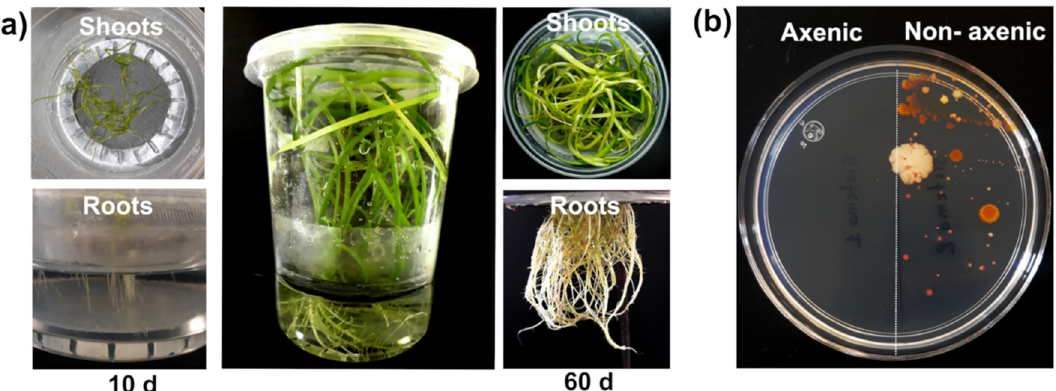
Figure 1. T. latifolia plants in an axenic hydroponic system ( a ) Side and top view of shoots and roots of ten and sixty-day-old T. latifolia plants in 0.2 × MS medium pH 5.7 supplemented with 1.0% glucose. ( b ) Evaluation of axenic conditions of the nutrient solution after sixty cultivation days of T. latifolia plants.